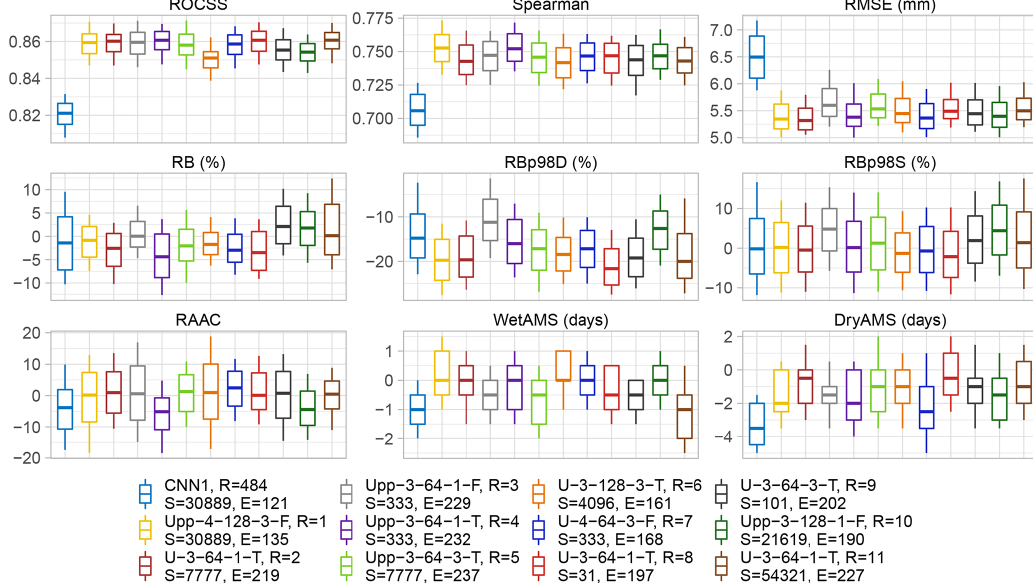
Figure A1. Same as Fig. 3 but without the filtering conditions applied.